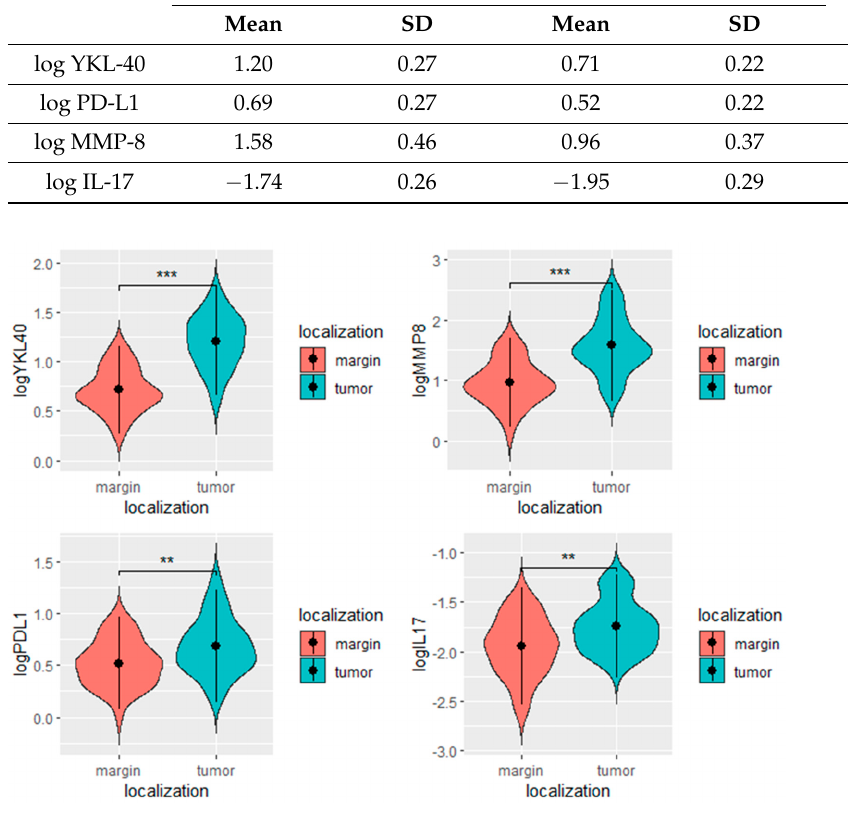
Figure 5. YKL-40, PD-L1, MMP-8, and IL-17 levels in the tumor and margin tissues. **** p < 0.0001. *** p < 0.001, ** p < 0.01, ns- not significant.